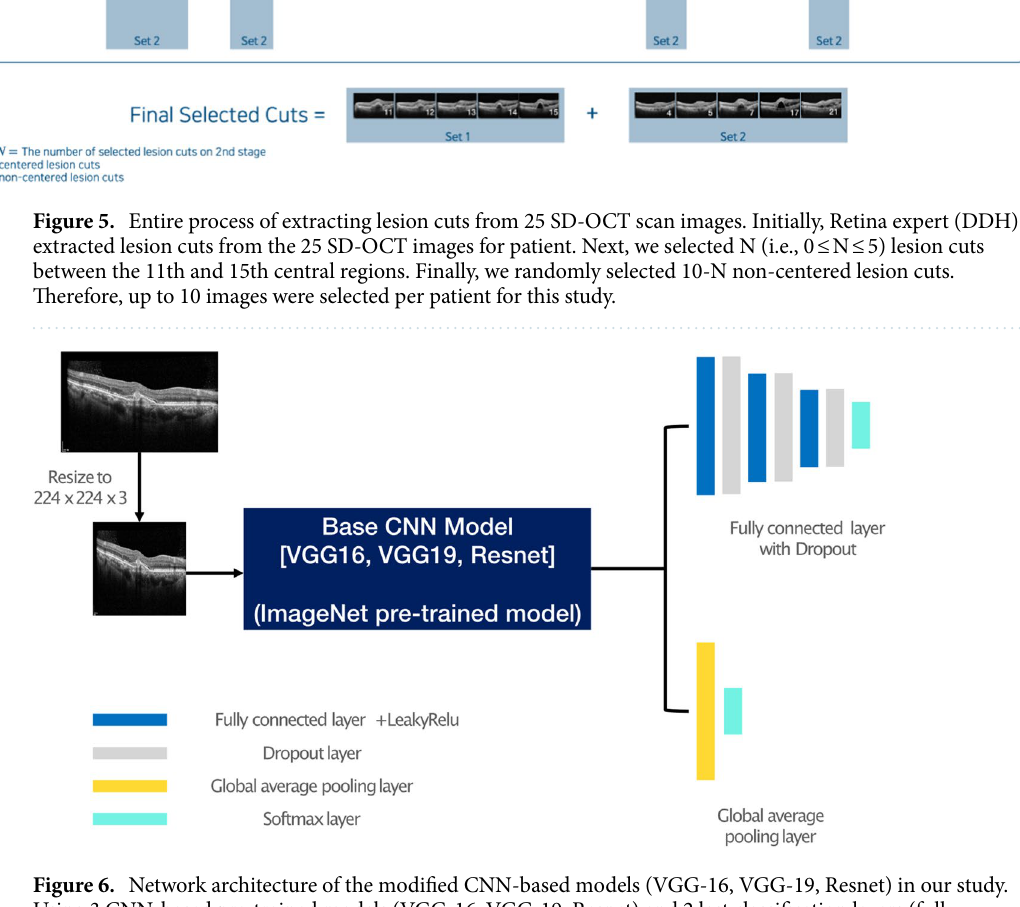
Figure 6. Network architecture of the modified CNN-based models (VGG-16, VGG-19, Resnet) in our study. Using 3 CNN-based pre-trained models (VGG-16, VGG-19, Resnet) and 2 last classification layers (fully connected layer with dropout and global average pooling), a total of 6 models were generated and used in this